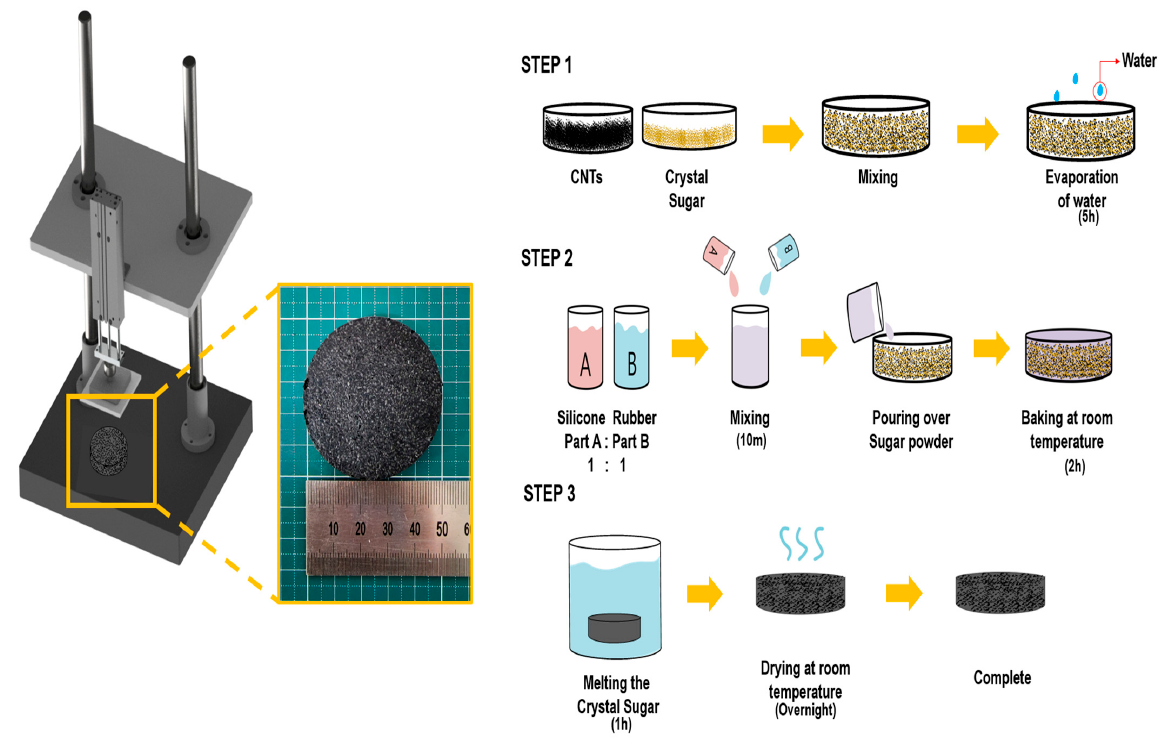
Figure 1. Manufacturing the FCS-TENG.